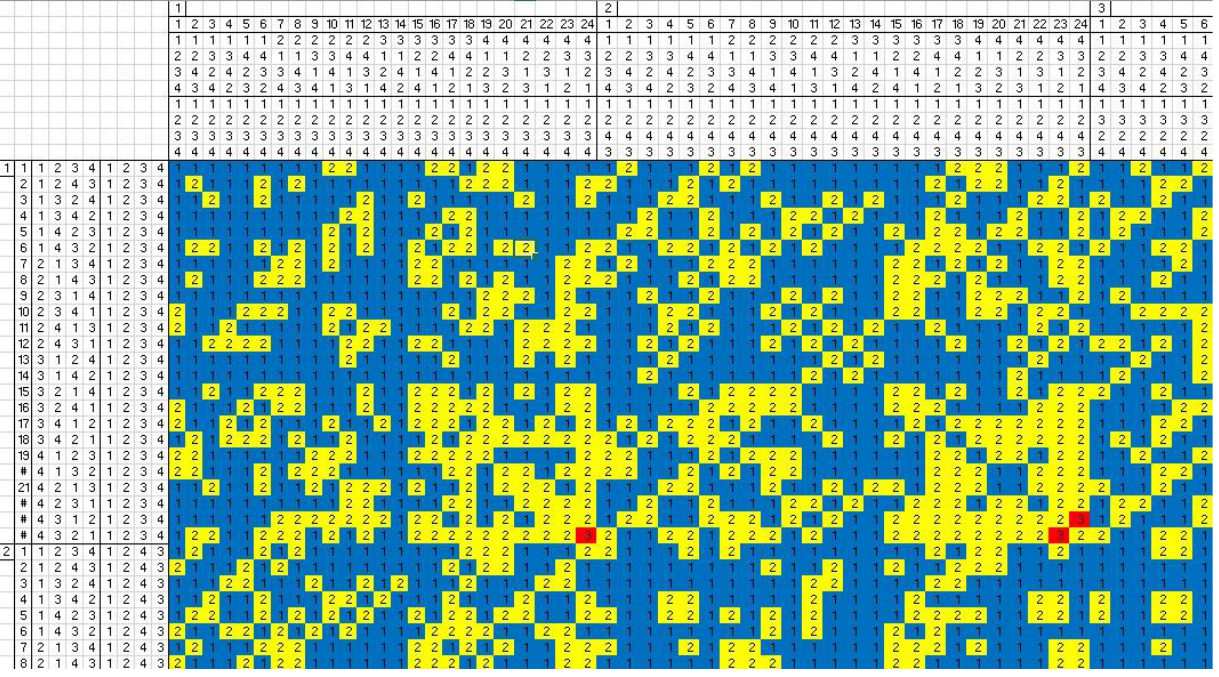
Figure 17. Accommodation of the combinations of columns of 4 × 4 matrices.